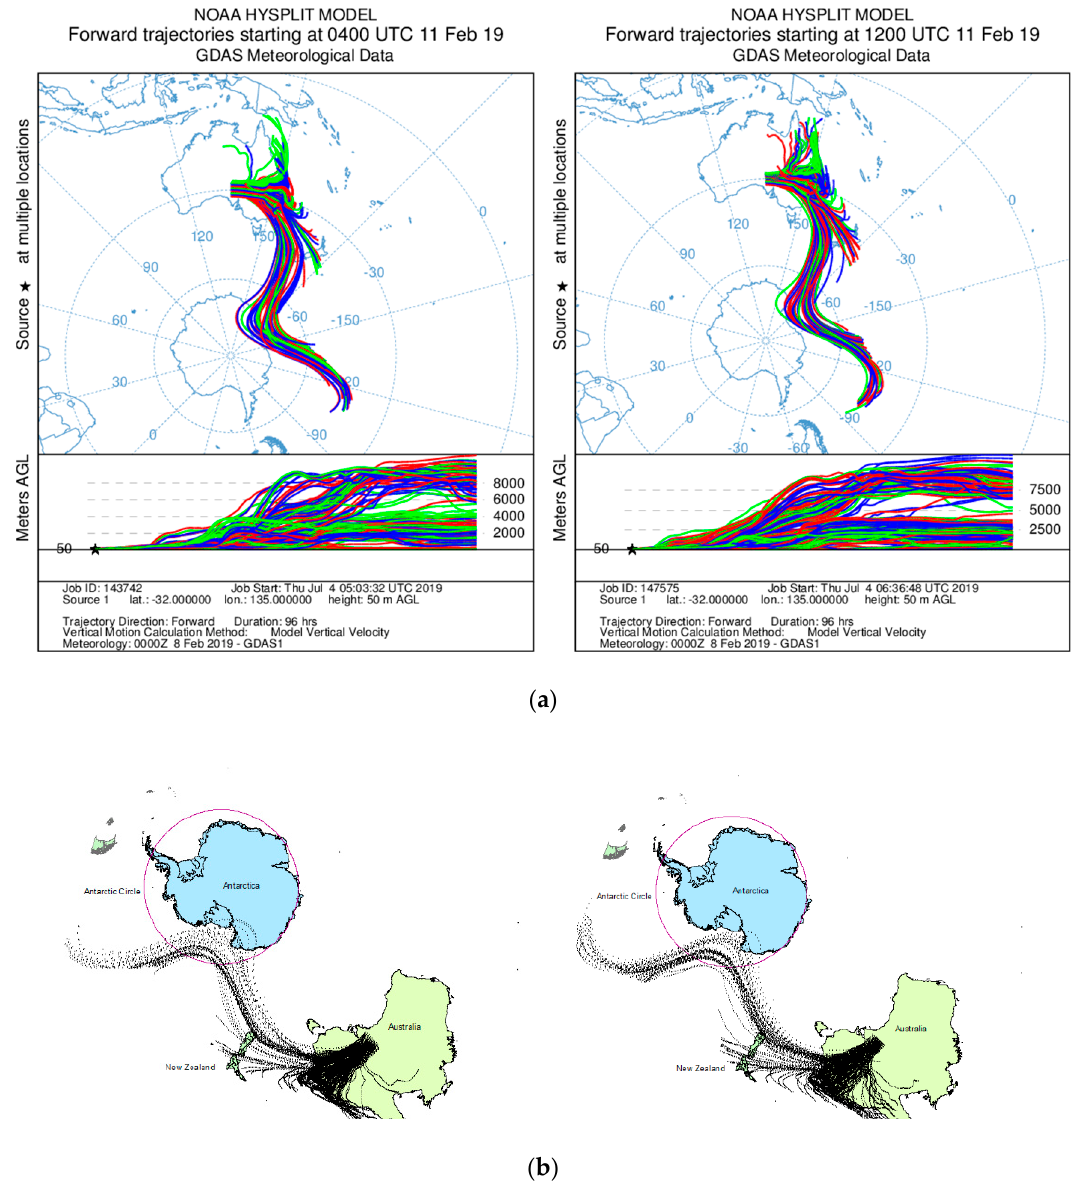
Figure 14. ( a ) NOAA HYSPLIT model matrix forward trajectory analysis from dust source areas in Central Australia with particle release times on 11 February 2019 4:00 UTC (left) and 12:00 UTC (right). ( b ) Same as ( a ), but using ArcGIS to display selected trajectories.